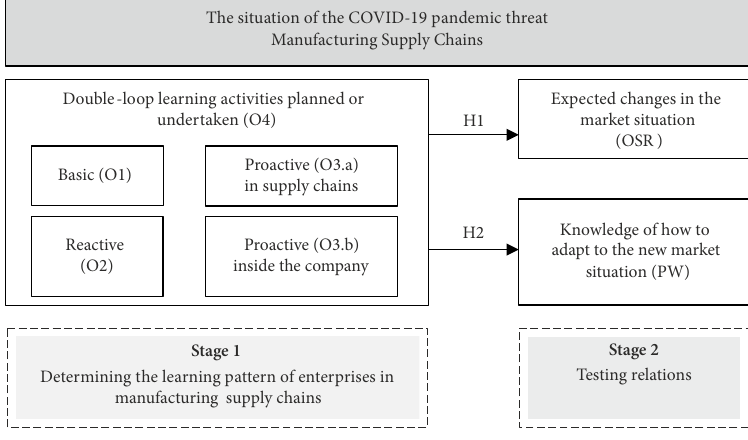
Figure 2. Research